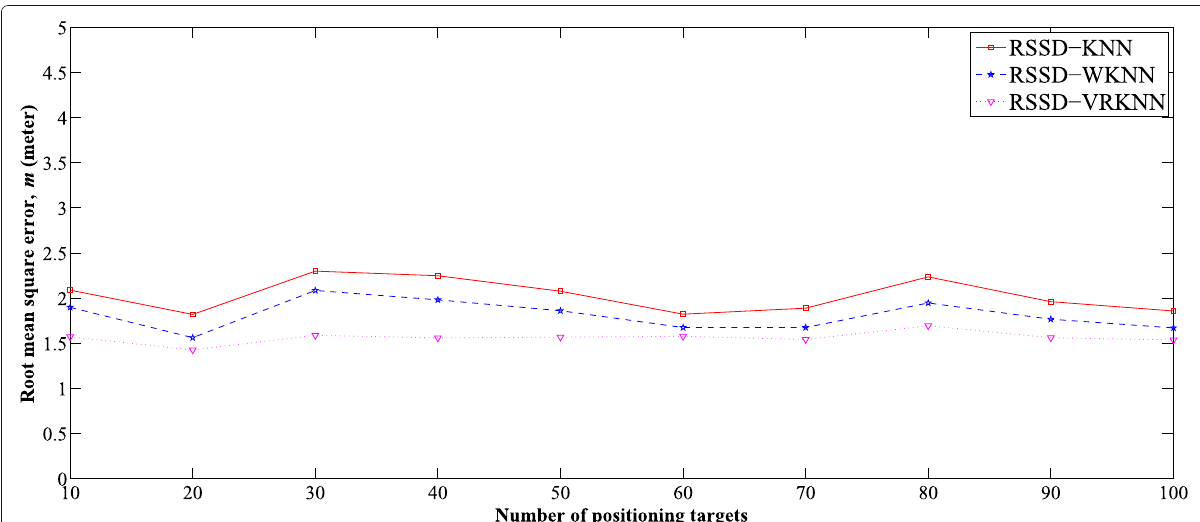
Fig. 13 RMSE comparison among RSSD-KNN, RSSD-WKNN, and RSSD-VRKNN. The number of positioning targets changing from 10 to 100 with 4 APs